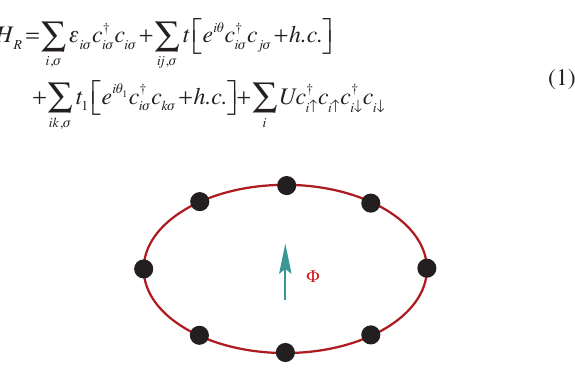
Figure 1 Schematic view of a 1D mesoscopic ring penetrated by a magnetic fl ux φ . The fi lled black circles correspond to the positions of the atomic